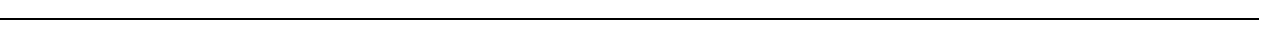
Fig. 1 CCP6 or CCP1 de fi ciency promotes cell reprogramming. a Ccp1 - or Ccp6 - de fi cient MEFs were lyzed for immunoblotting. β -actin was used as a loading control. b WT or CCPs-de fi cient MEFs were infected by OSKM factors containing retrovirus and cultured in ESC media for 3 weeks. Alkaline phosphatase (AP)-positive colony numbers per 10 4 cells were calculated and shown as means ± S.D. **, P < 0.01. Scale bar, 50 μ m. n = 5. c SSEA-1 was assayed by fl ow cytometry in iPSCs derived from Ccp1 − / − or Ccp6 − / − MEFs. d iPSCs from Ccp1 − / − or Ccp6 − / − MEFs were injected subcutaneously into NOD/SCID mice.